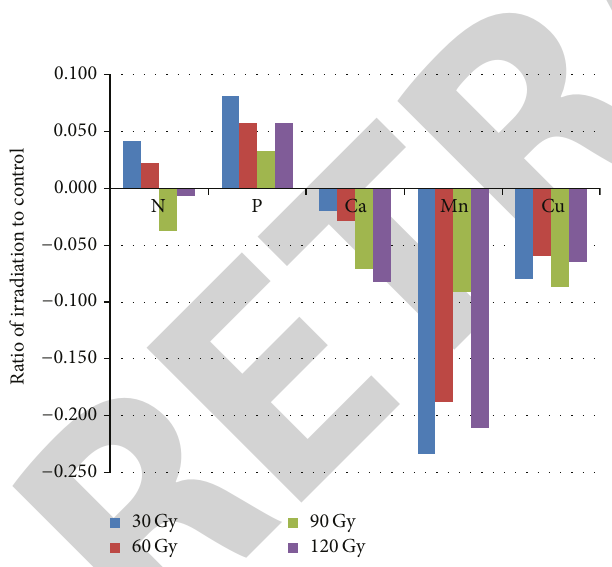
Figure 4: Ratio of element contents in gamma-irradiated seeds to non-irradiated (control)